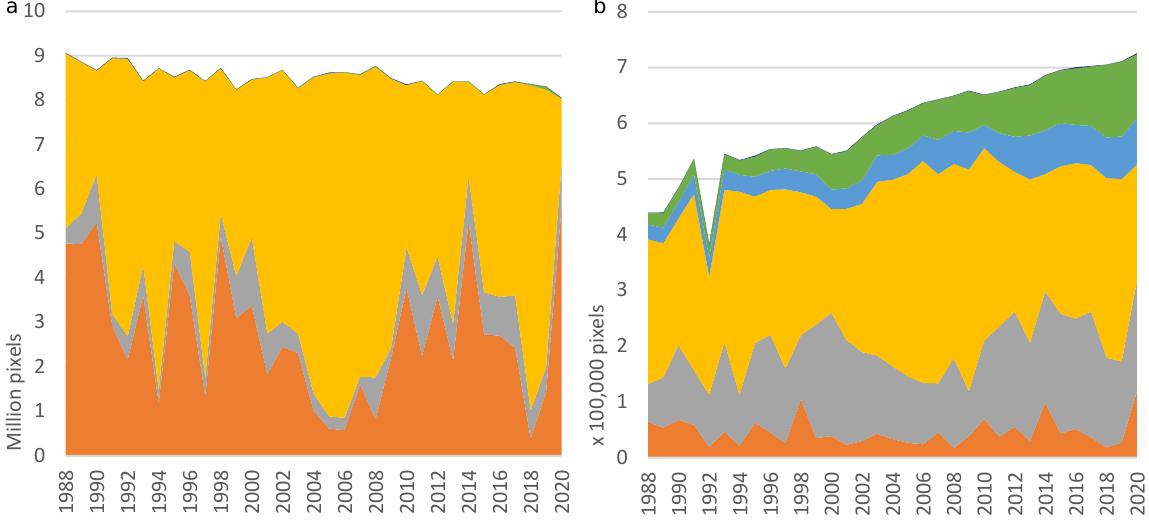
Figure 8. DEA Land Cover classes that correspond to the U-Net CNN model Grassland class ( a ); and Built-up class ( b ). Legend as for Figure 7.